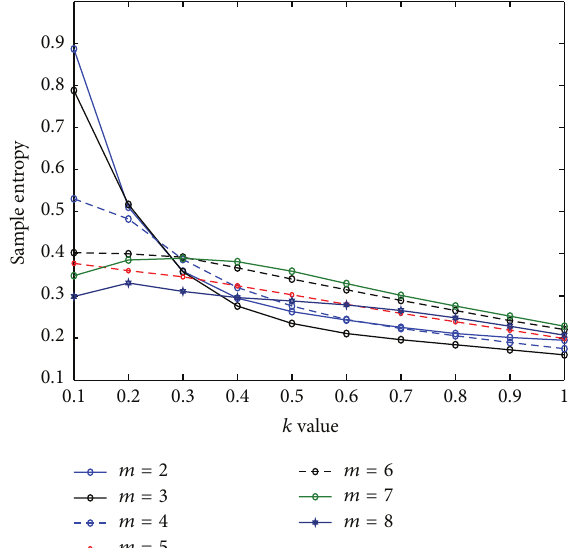
Figure 4: The calculated ApEn values by different parameters ( 𝑘 value and 𝑚 ).